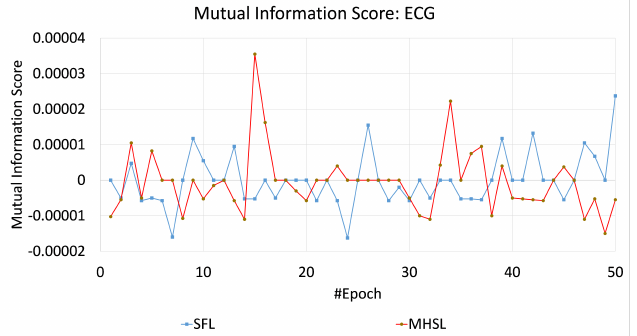
Figure 3. Mutual information score across the epochs for SFL and MHSL for the ECG dataset.